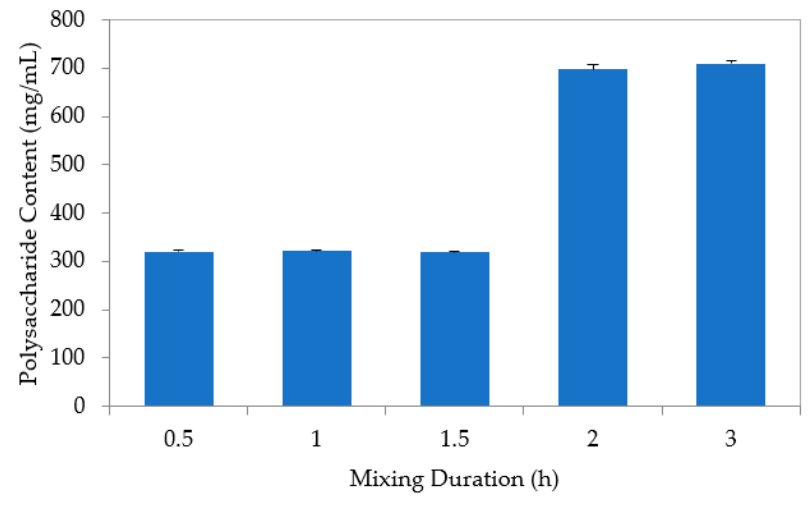
Figure 3. Polysaccharide extraction on different mixing duration.